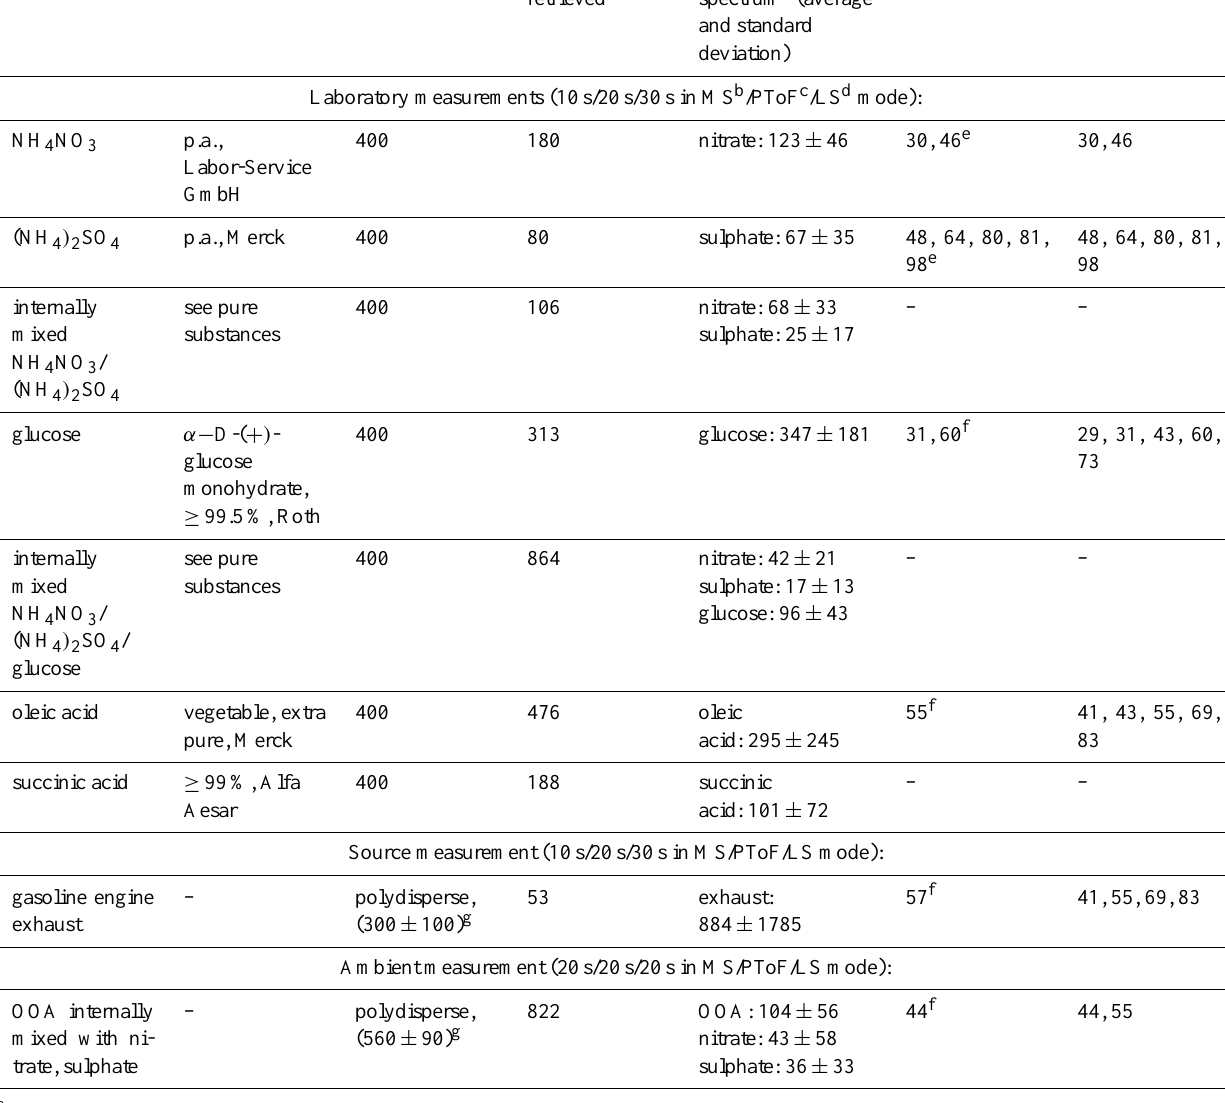
Number of single-particle mass spectra retrieved